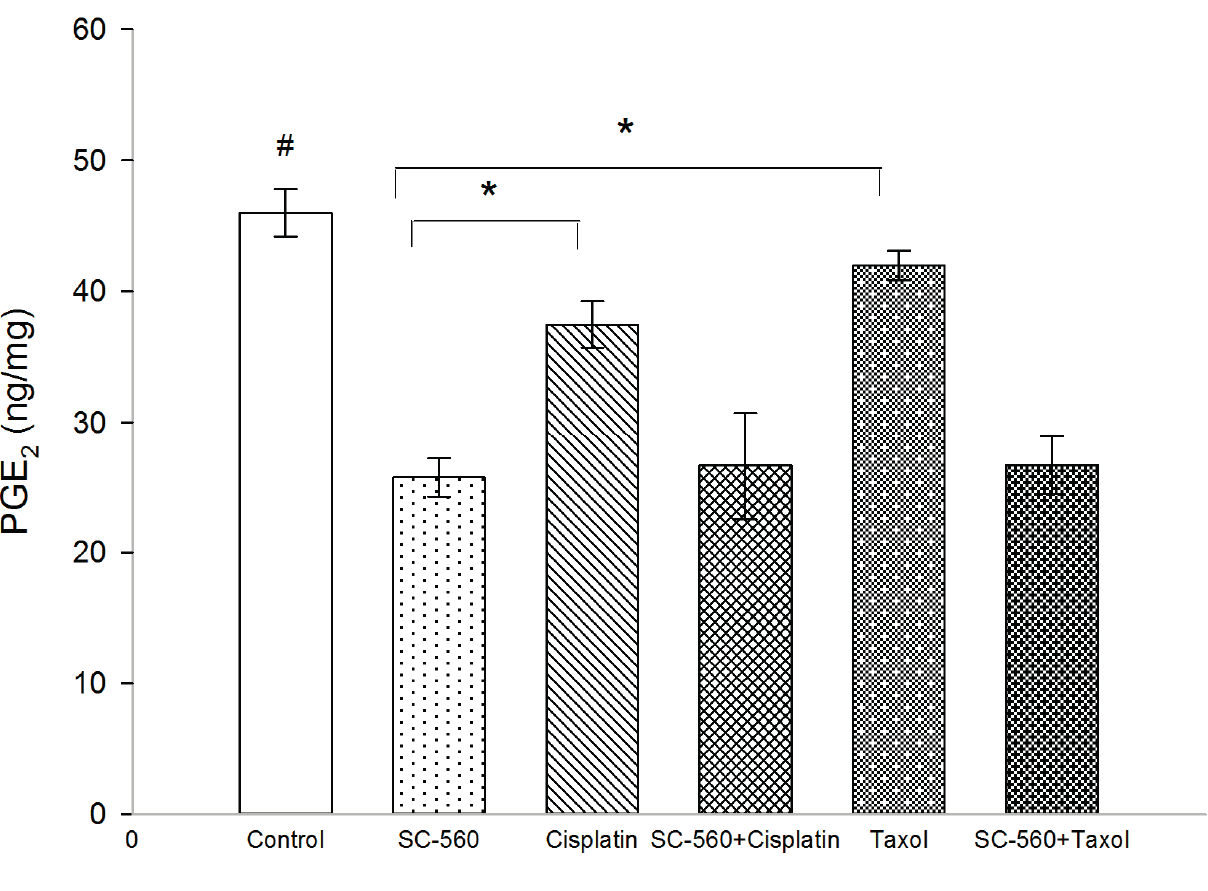
error bars indicate standard